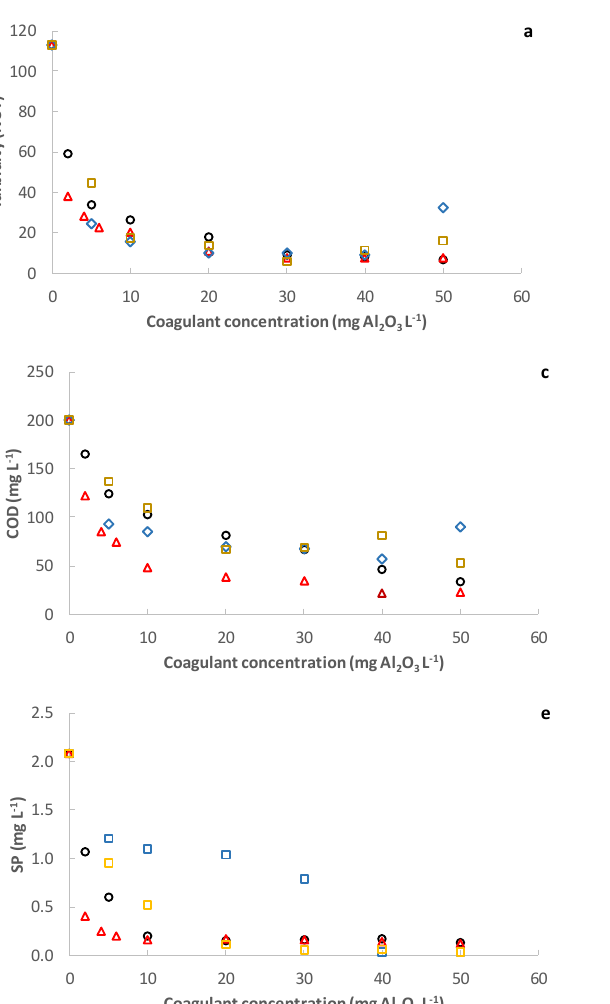
continuous lines represent linear fits.